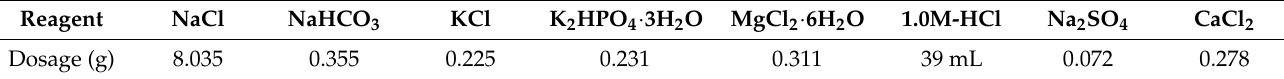
Table 6. Reagents and dose for 1000 mL